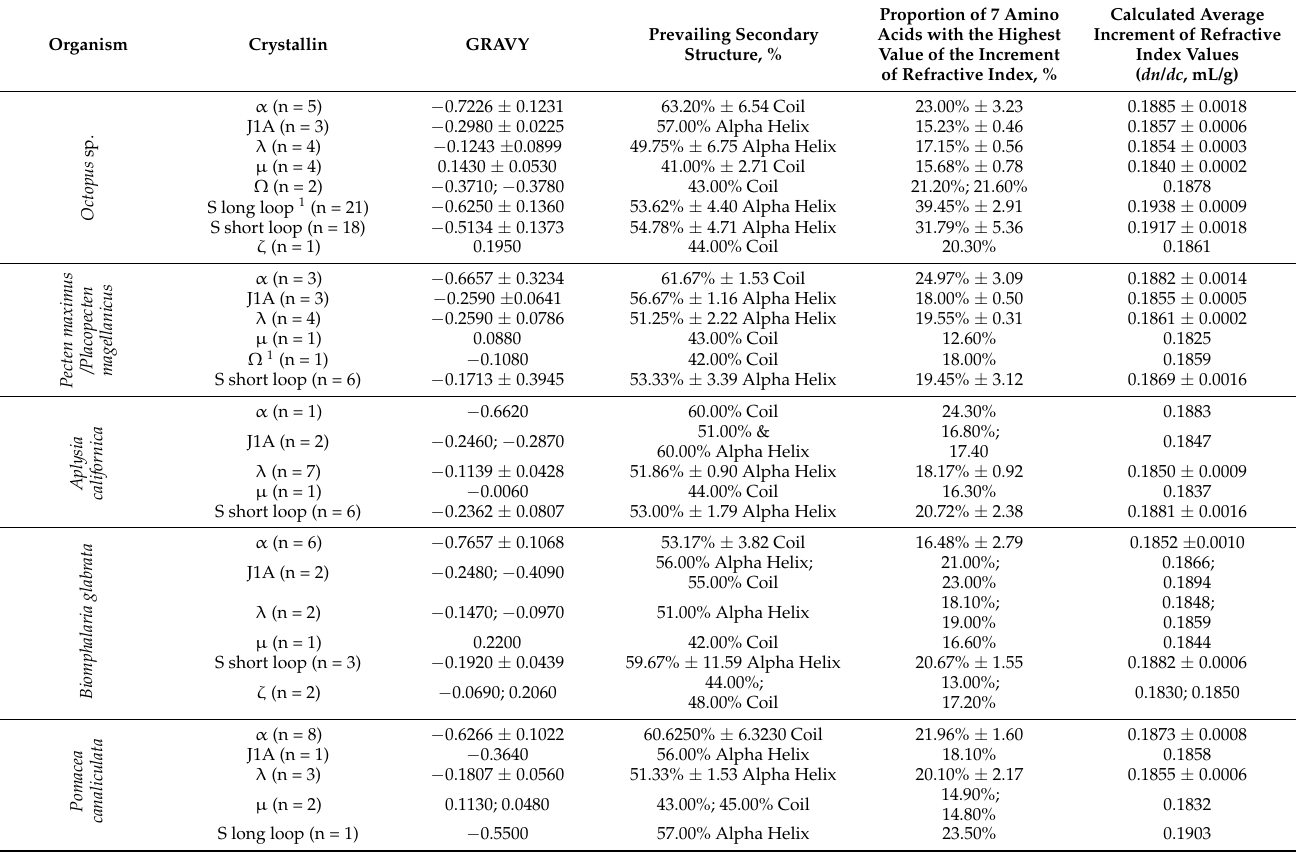
Table 3. Main structural and physicochemical parameters of known mollusc